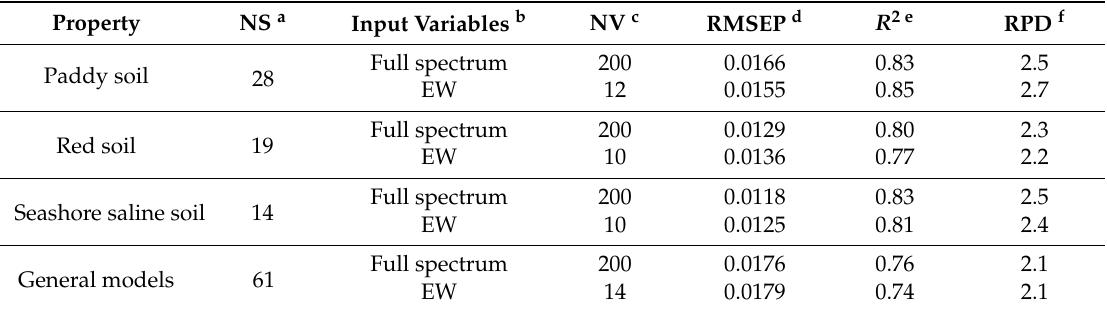
Table 3. Comparison of prediction results for soil nitrogen using different sample sets and input variables.